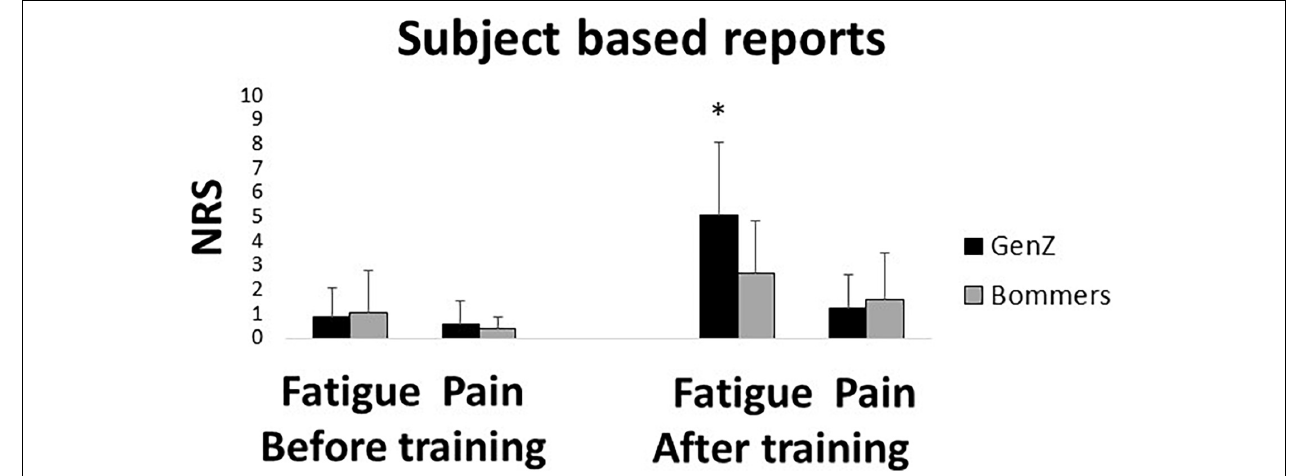
FIGURE 4 | Mean and standard deviation of the subject-based reports on fatigue and pain, before and after the training exercises in the Gen Z ( N = 16) and Baby Boomer age groups ( N = 16). Asterisks denote significant differences between the groups ( p =